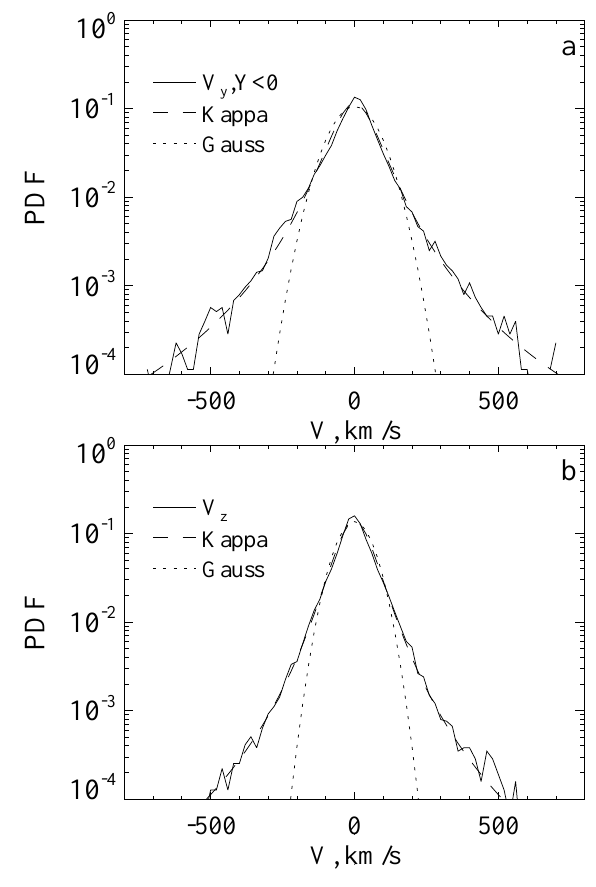
Fig. 3. Comparison of the experimental PDFs with the Gaussian and kappa function fits: (a) V y for Y < 0; (b) V z